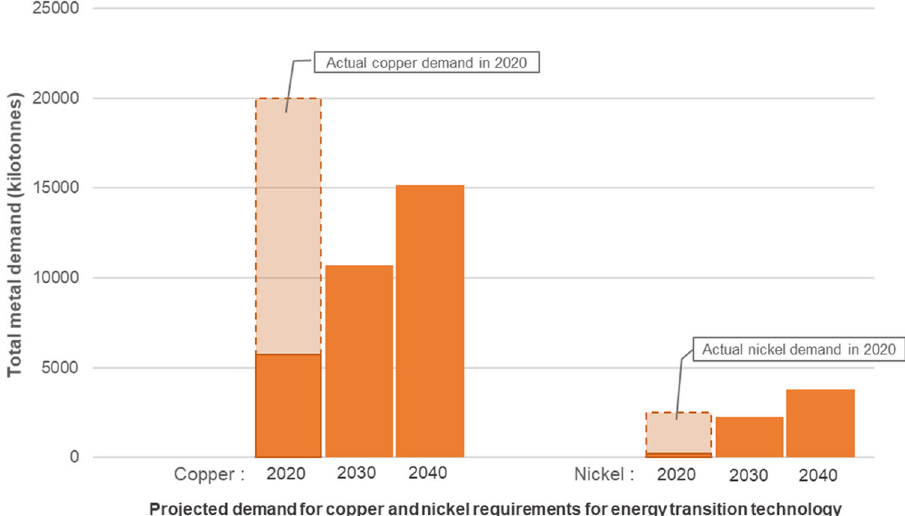
Fig. 1 Projected demand change for copper and nickel requirements for energy transition technology. Projected demand for copper and nickel required for low-carbon technology generation, electric vehicles, and battery storage (solid, orange bars) compared to the actual total metal demand (for all purposes) in 2020, using data from the International Energy Agency 2020 datasets on the metal demands requirements to achieve the Paris Accord global warming targets. This fi gure shows that in 2020 total global copper demand (dashed, transparent orange) was 20 million tonnes, of which 5.7 million tonnes, shown in the darker orange, solid bar was projected for use in energy transition technologies.